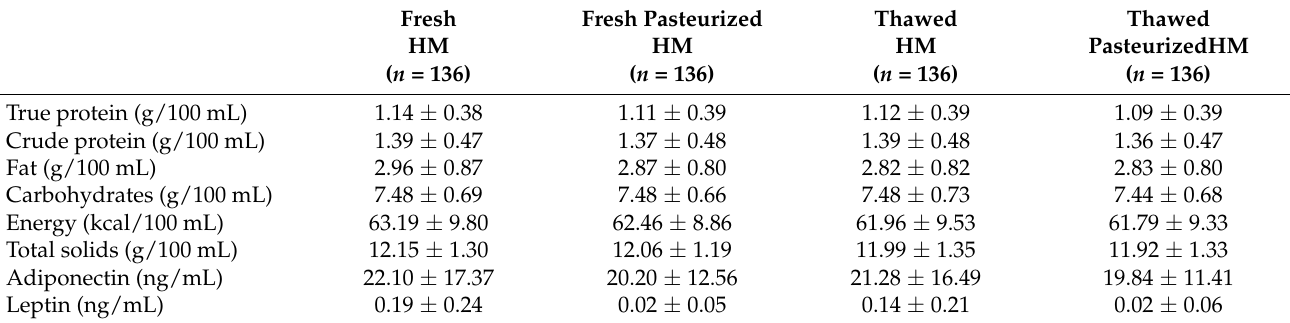
Table 2. Human milk nutrient compositions in different processing types.